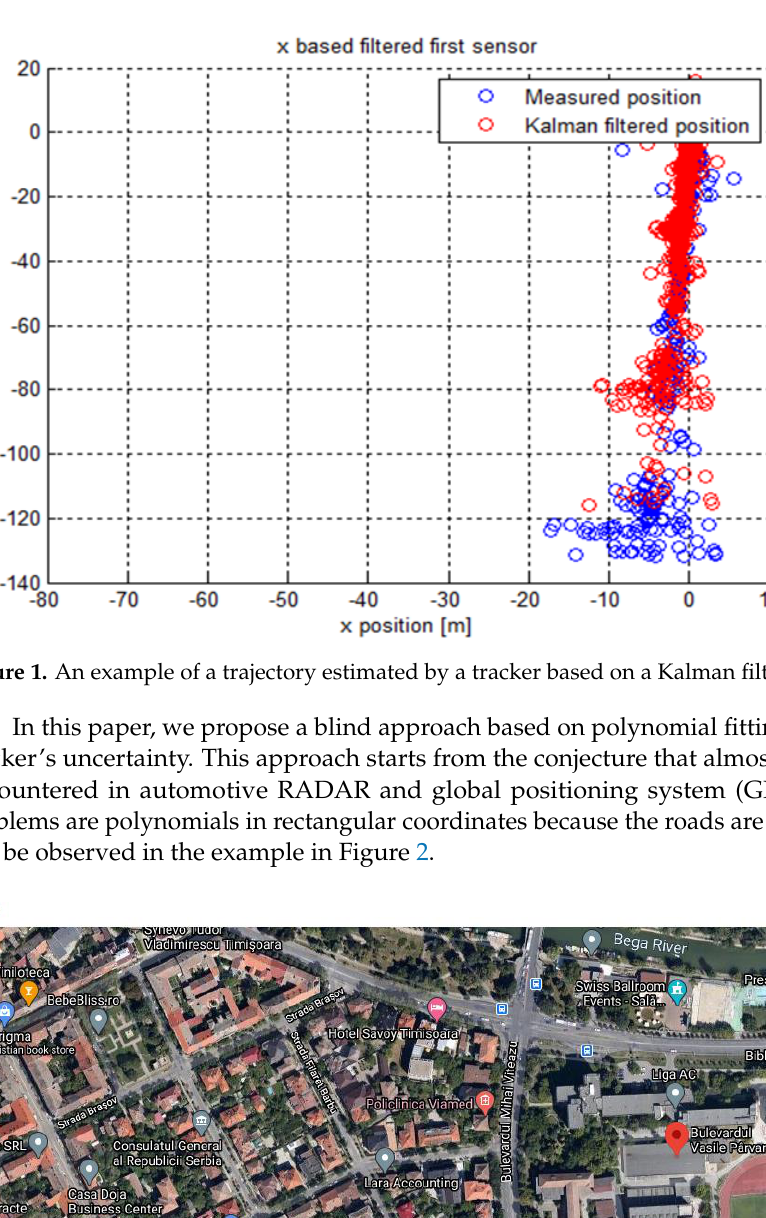
Figure 1. An example of a trajectory estimated by a tracker based on a Kalman filter.